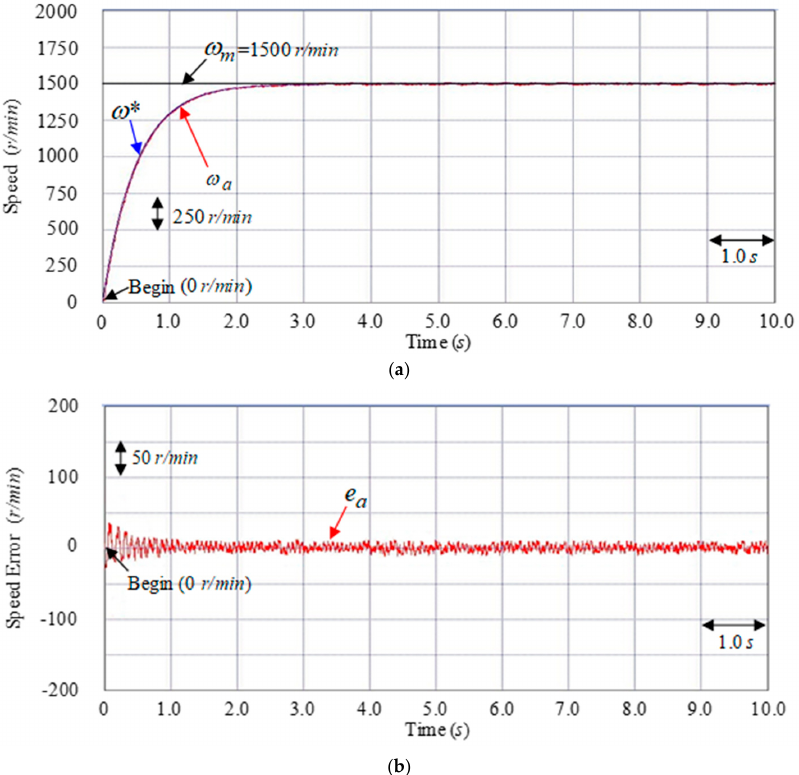
Figure 12. Tested results for the SIM expelling CVT organized system obtained at the tested Event E1 case by using the controller CT3: ( a ) speed response, ( b ) speed discrepancy response. Mathematics 2020 , 8 , x FOR PEER REVIEW